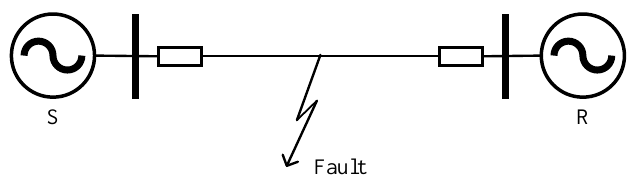
Figure 4. 735-kV, 60-Hz, 100-km transmission system